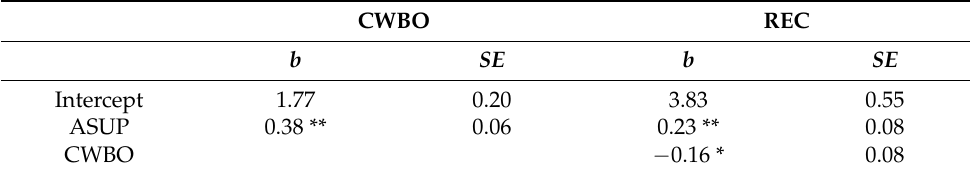
Table 4. Study 1 Mediation Results.